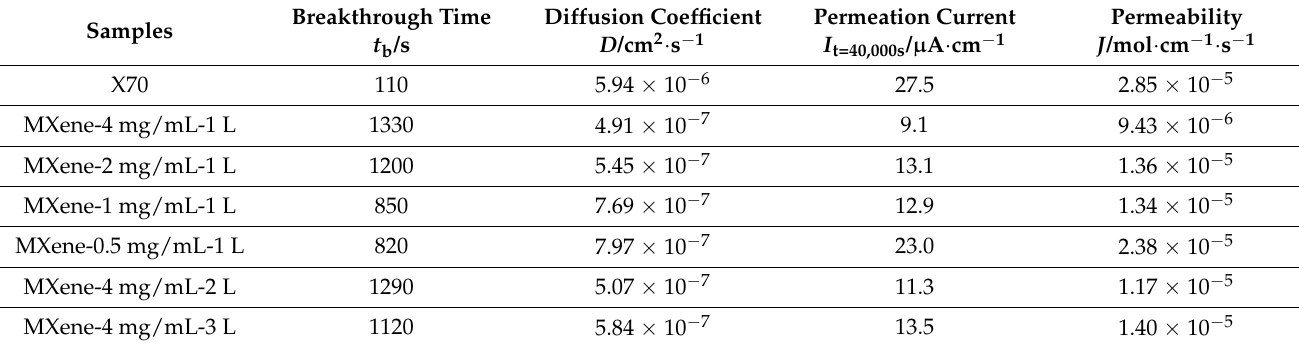
Figure 5. ( a , b ) Electrochemical hydrogen permeation curves; ( c ) Strain–stress curves of the uncoated and coated samples (MXene-4 mg/mL − 1 L) after electrochemical hydrogen charging; Fracture morphologies of ( d ) X70 without hydrogen charging, ( e ) X70 with hydrogen charging, and ( f ) MXene-4 mg/mL − 1 L with hydrogen charging. Table 1. Permeation parameters derived from the hydrogen permeation curves.